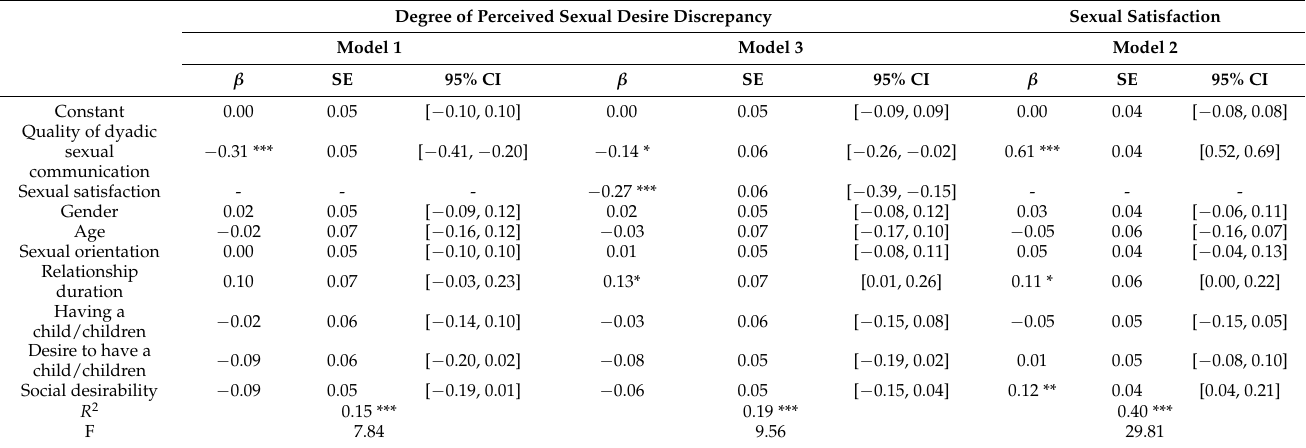
Table 2. Results of the three mediation